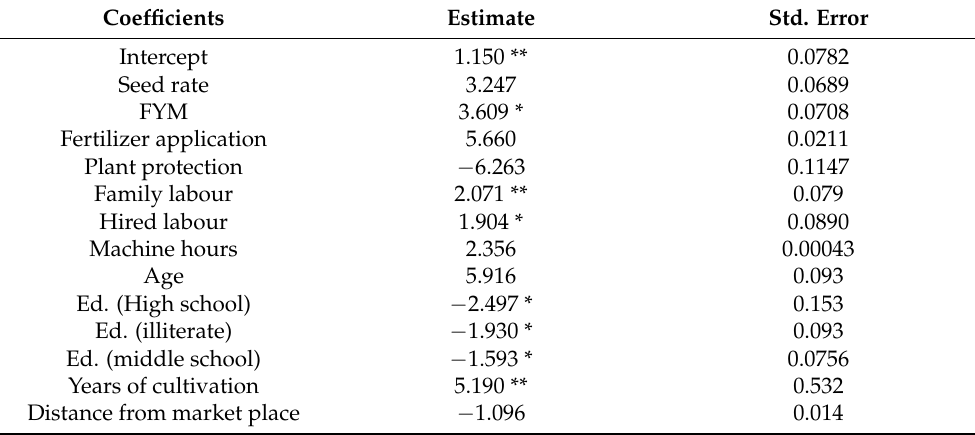
Table 14. Tobit regression estimates of determinants of income of farmer from marigold crop.